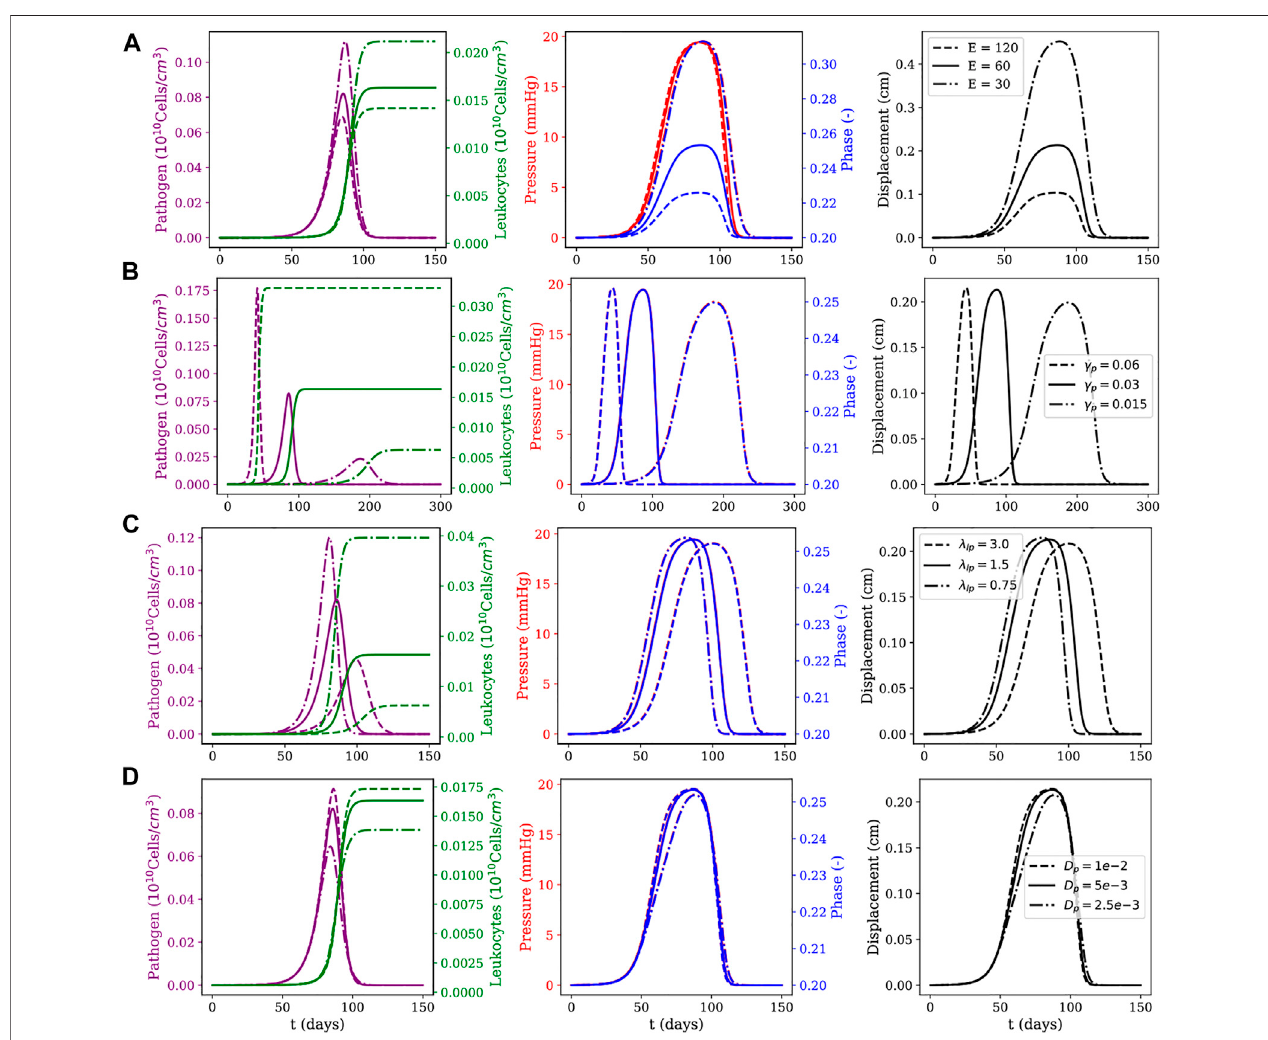
FIGURE 6 | Diffuse myocarditis: evolution of pathogens and leukocytes concentration, pressure, fl uid phase, and displacement over 150 days of simulation for different parameter sets.The fi rst row (A) shows the effects ofYoungmodulus E (as computed from the Lamé parameters for the neo-Hookean model); the second row (B) shows the effects of the pathogen reproduction rate γ p ; the third row (C) shows the effects of the phagocytosis rate λ lp ; and the last row (D) shows the effects of the pathogens ’ diffusion coef fi cient d p . For each row, three scenarios for the parameter under study are considered: one using the reference value described in Table 1 , one using its value doubled and one using its value